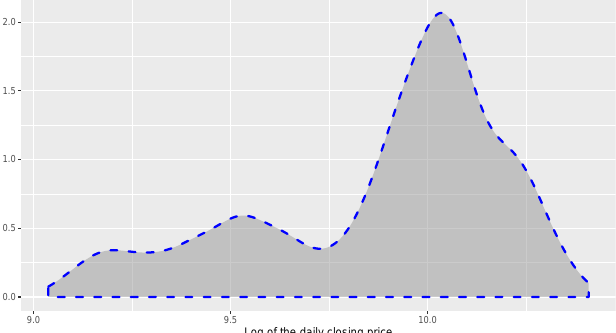
Figure 3. Density of log of the daily closing price of Hong Kong Hang Seng Index.